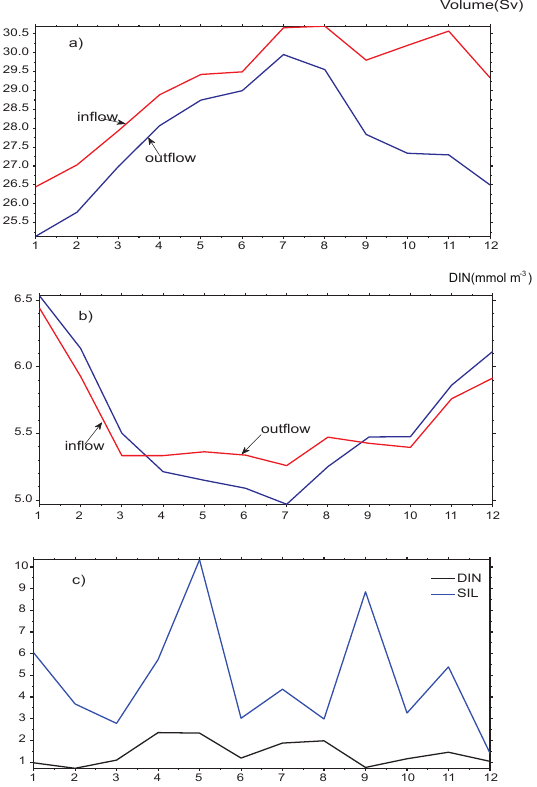
Fig. 10. (a) monthly inflow and outflow volume transports (Sv) across the 200-m isobath. (b) Monthly mean nitrate concentrations (mmolm − 3 ) in the inflow water and outflow water. (c) Seasonal variation of vertically averaged nitrate (black line) and silicate (blue line) concentrations above 200m depth at the southern open bound- ary (123 ◦ E, 24 ◦ N).